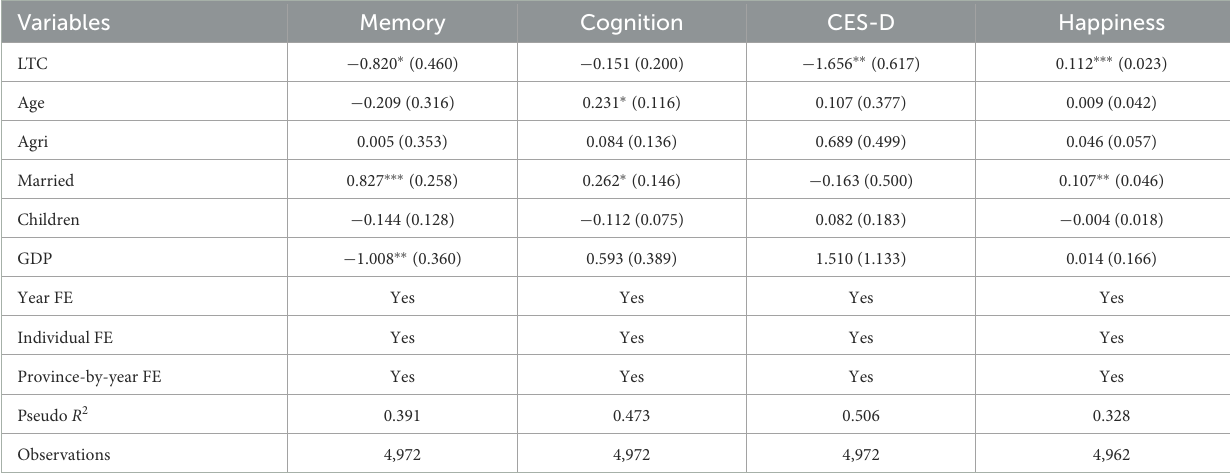
TABLE 5 The effects of LTCI on older people’s mental health. Variables